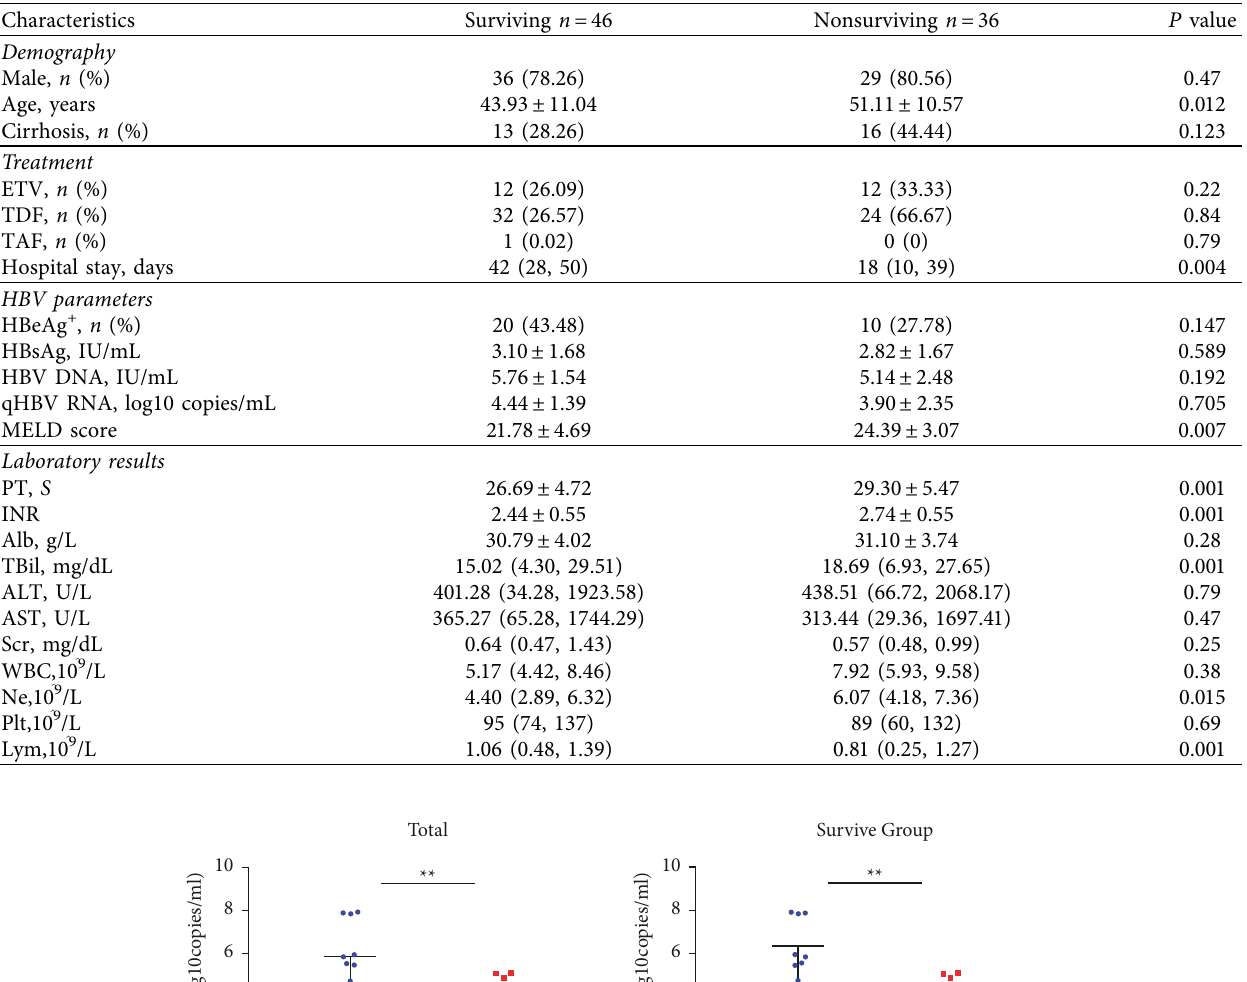
Table 2: The comparison of the surviving and nonsurviving patients with HBV-ACLF.